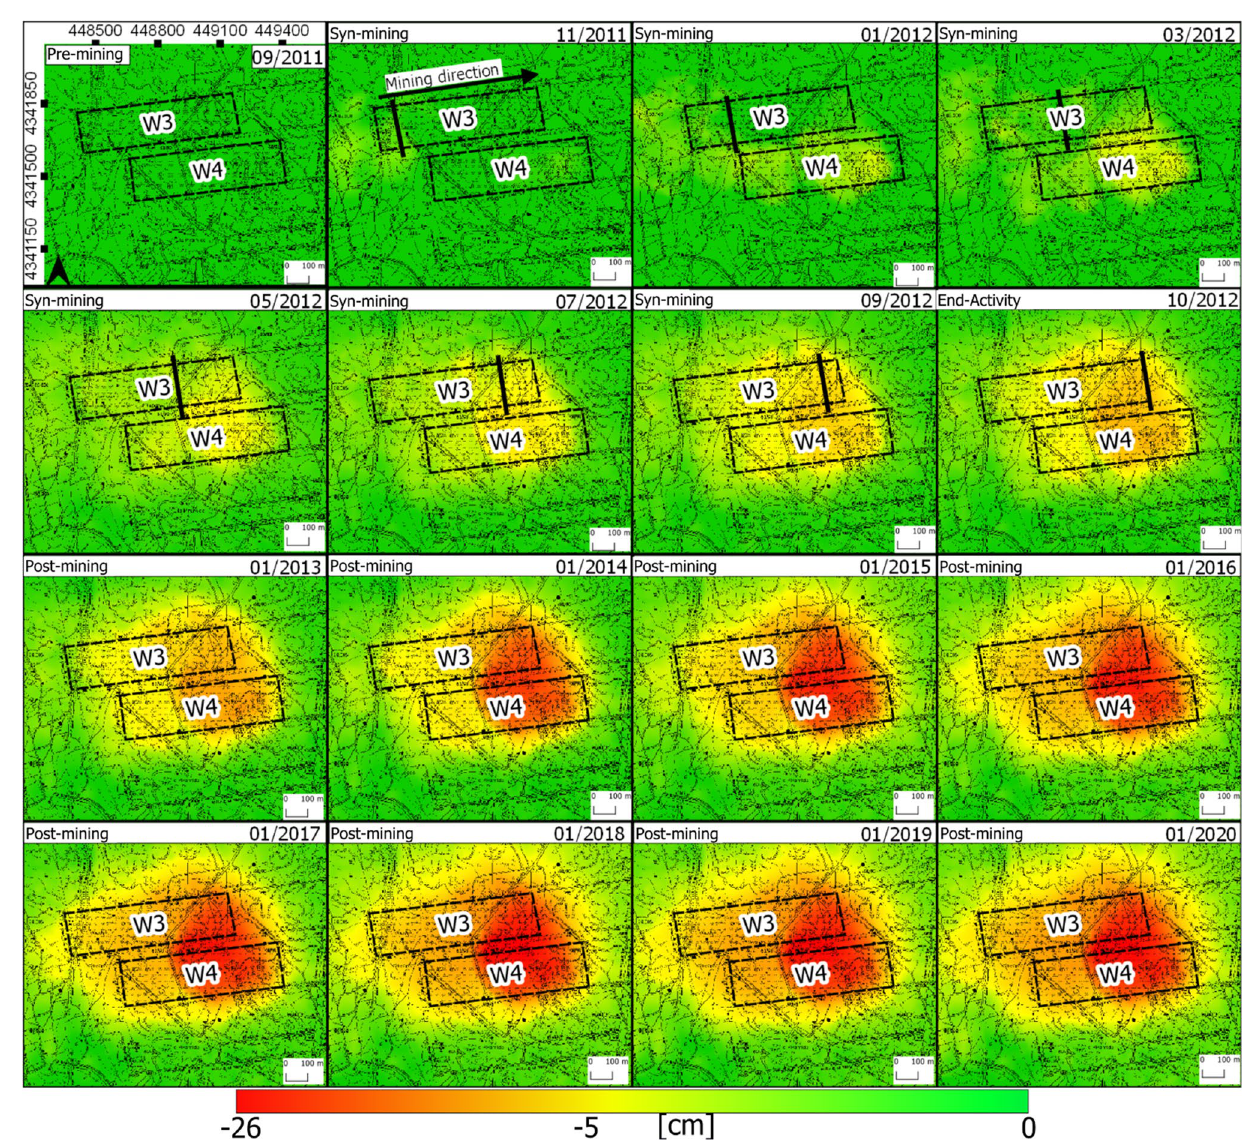
Fig. 8 Vertical deformation maps pre-mining, syn-mining, and post-mining activity. Black dashed lines in the figure represent the mining